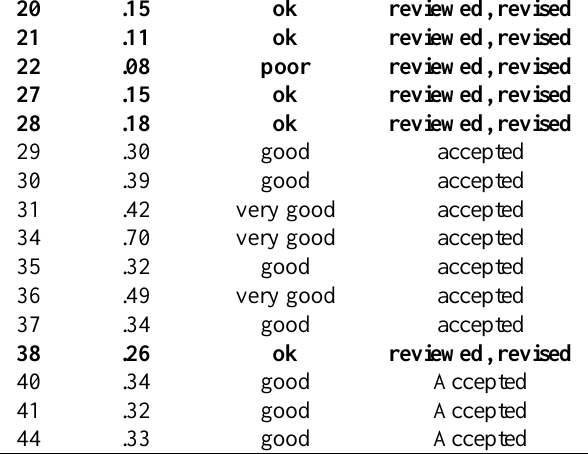
TABLE 6 | Result of Simple Linear Regression Test